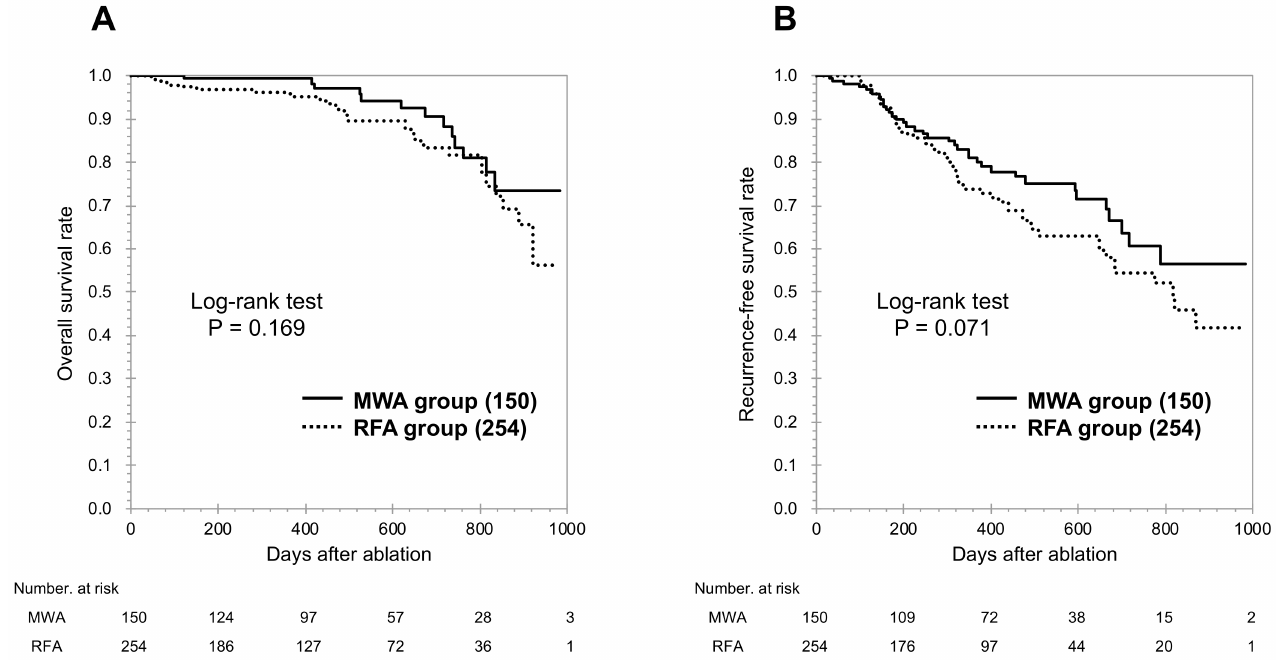
Figure 2. Kaplan-Meier curves for overall survival (OS, A ) and recurrence-free survival (RFS, B ) among all patients. No significant differences were observed between the groups that underwent microwave ablation (MWA) and radiofrequency ablation